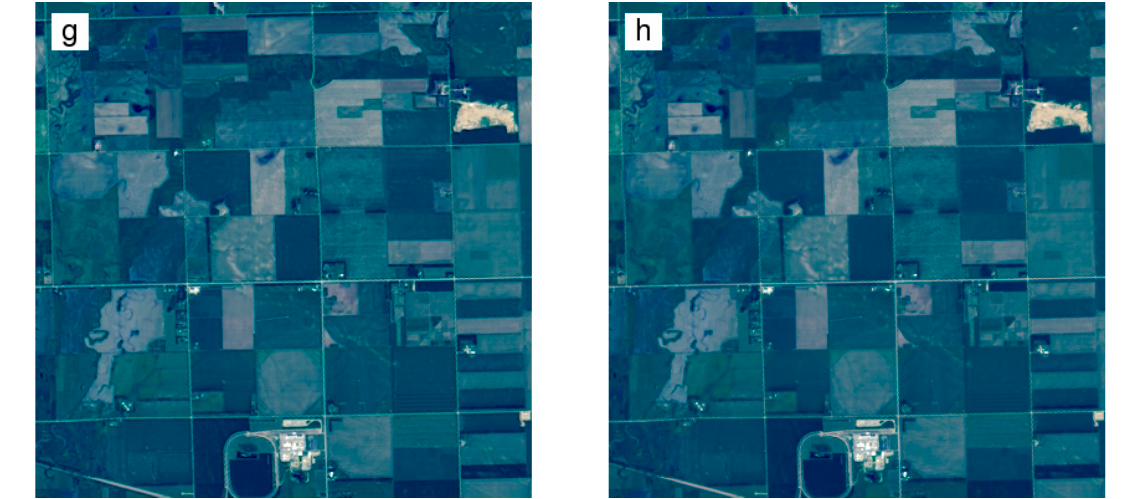
Figure 6. South Dakota illustrative 400 × 400 (15 m) pixel subset. Top row: 15 m TOA panchromatic reflectance ( a ) and 30 m true color (red, green and blue) TOA reflectance cubic convolution resampled to 15 m ( b ); The following rows show 15 m true color Brovey (left column) and context adaptive Gramm-Schmidt (right column) pansharpened reflectance respectively, derived using intensity images computed using the equal ( c , d ); spectral response function based (SRFB) ( e , f ); and image specific spectral weights ( g , h ) summarized in the Figure 3 caption.